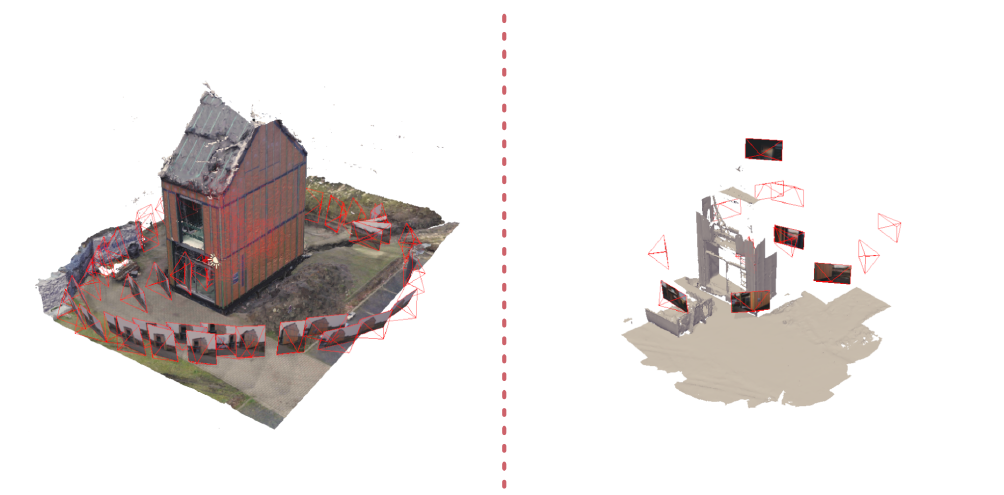
Figure 1. Examples of a reference dataset and a local measurement session of the same structure, taken at different times with different sensors. The localised images in relation to the geometry are displayed in